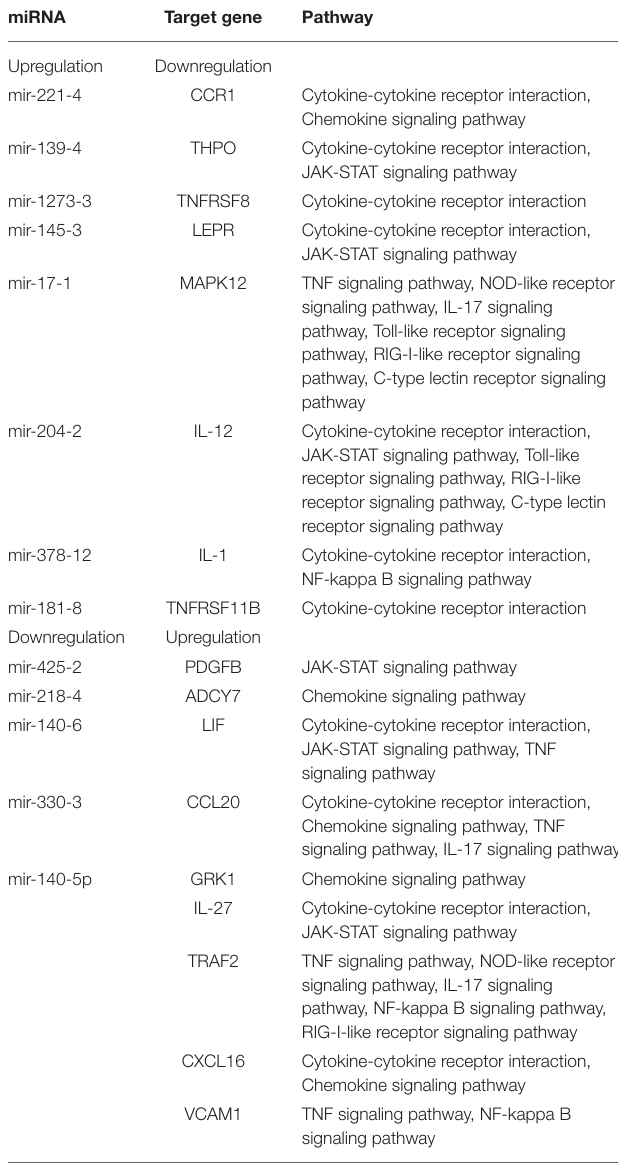
TABLE 1 | Relationships between miRNAs and inversely correlated target genes. miRNA Target gene